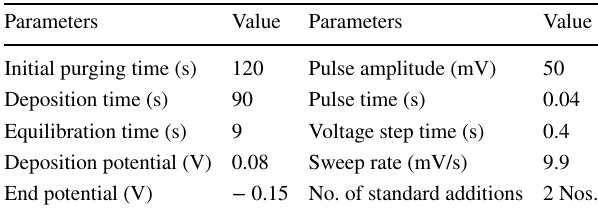
Fig. 1 U peak ( y -axis current in nA; x -axis voltage) in sample solu- tion observed through standard addition method Table 1 DPAdSV method parameters optimized for U